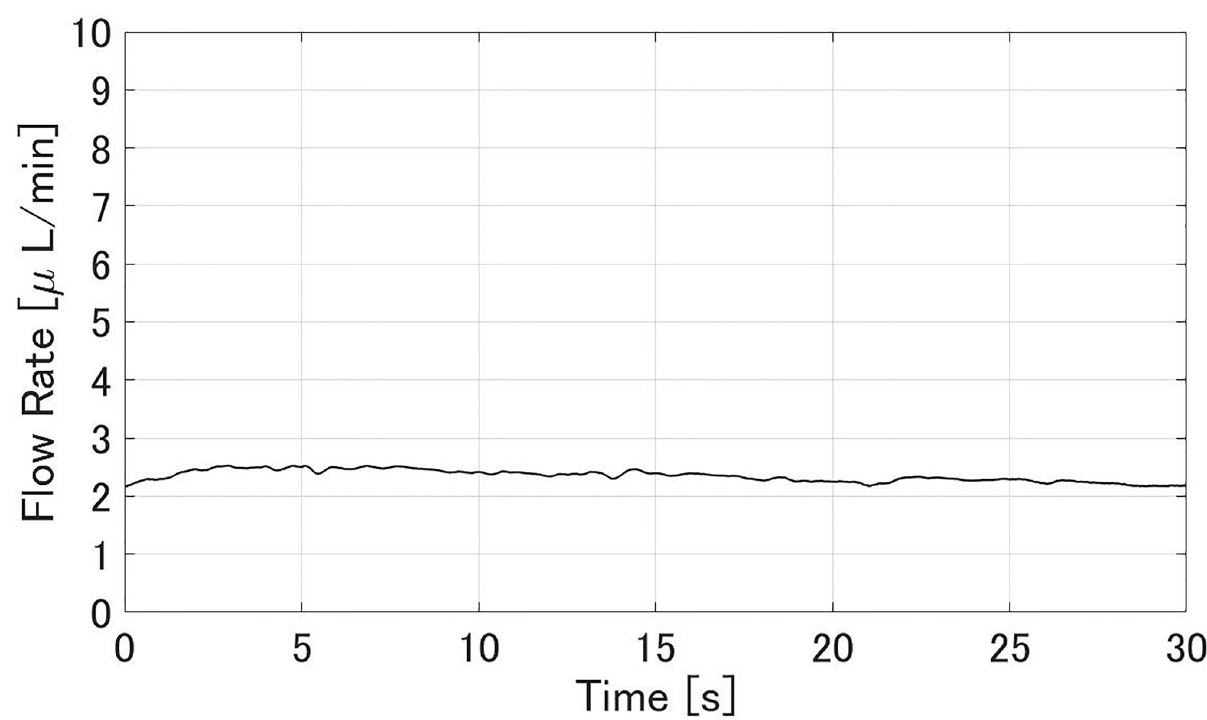
Fig 10. An experimental result of the flow rate Q after cleaving the TM membrane and adhesively closing the small incised part in the cornea. The sampling interval was 0.07 s. Q was 2.4 ± 0.2 μ L/min.